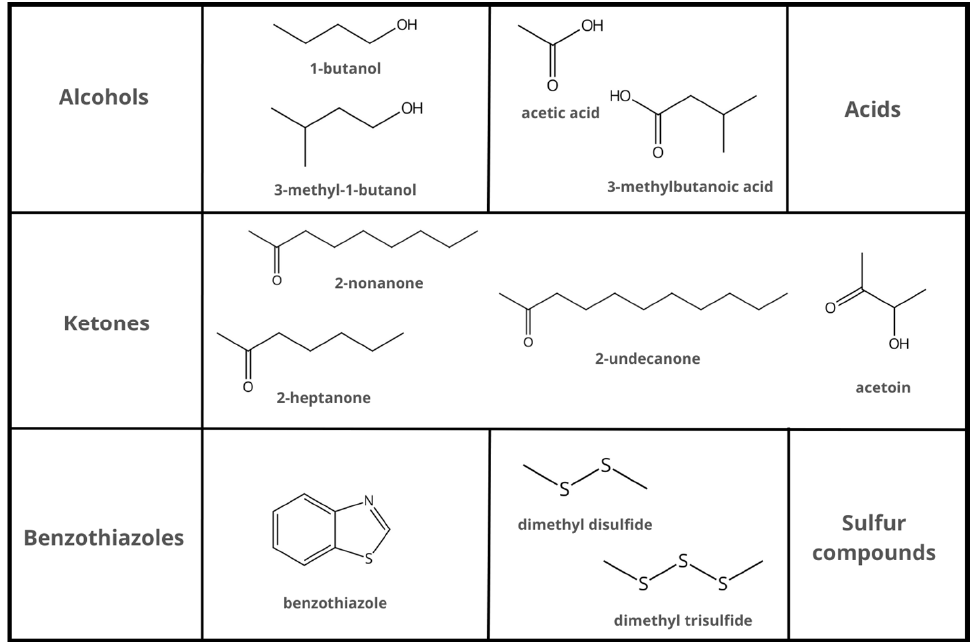
Figure 4. The most common antifungal VOCs produced by Bacillus spp.